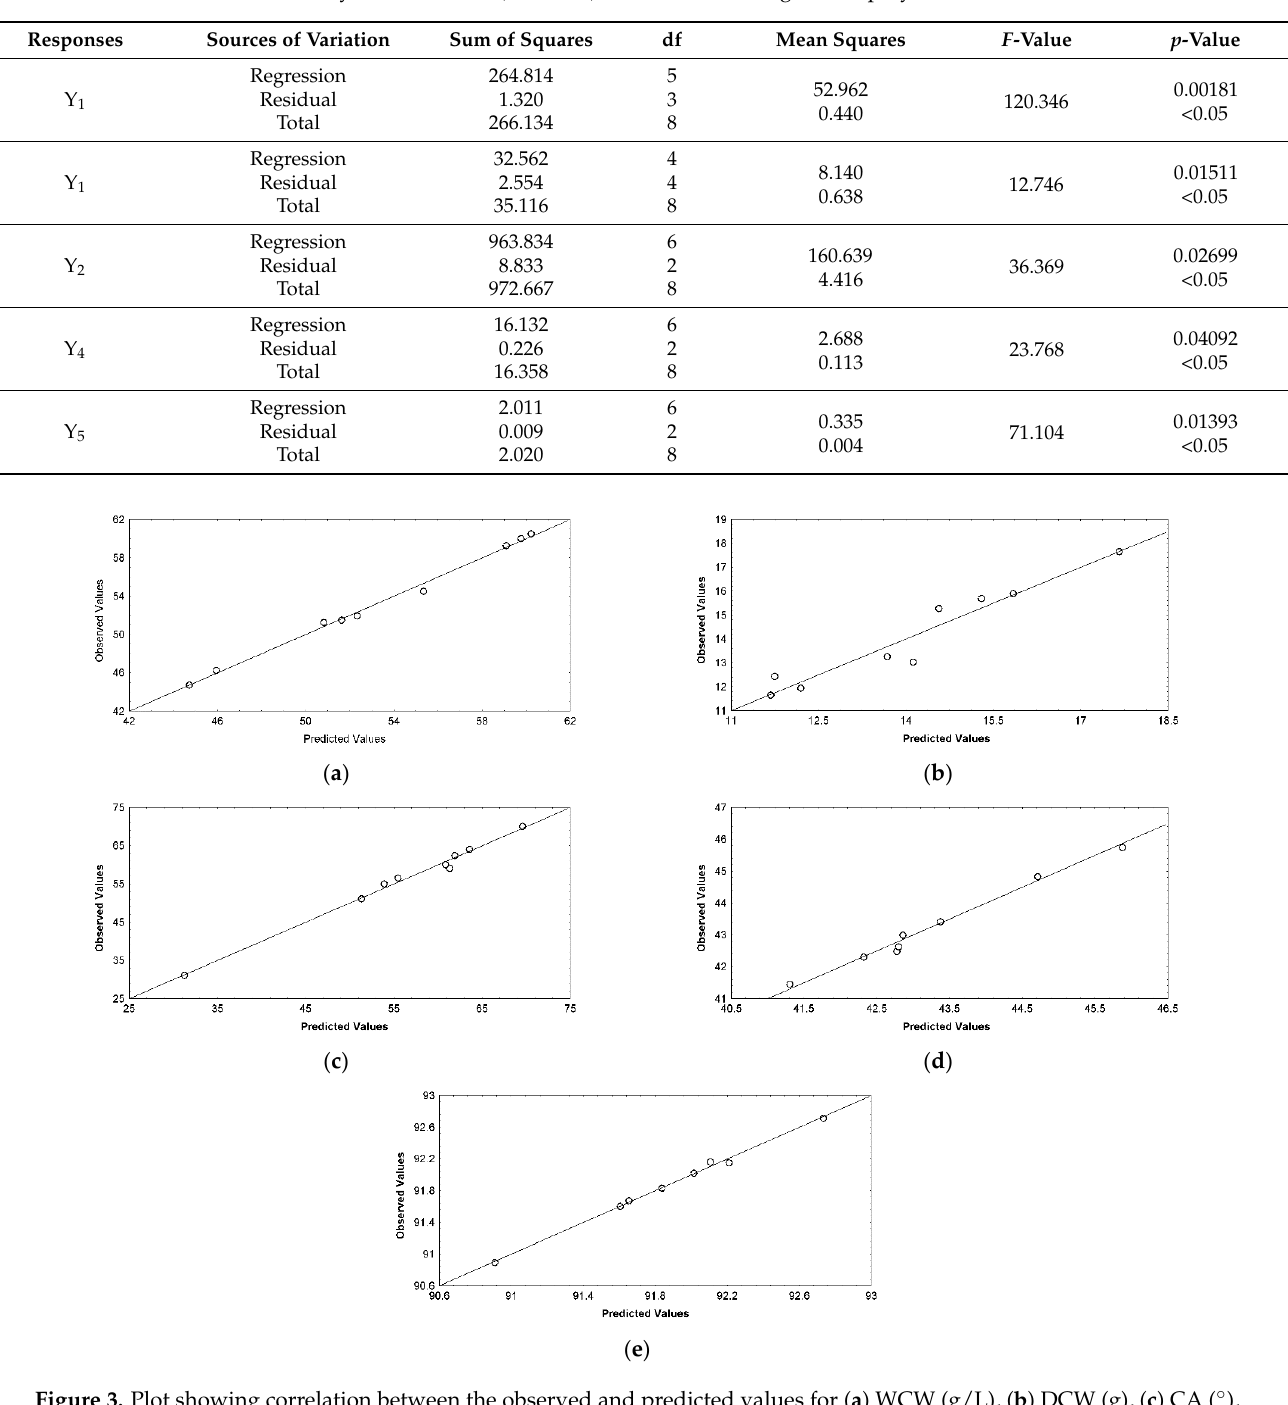
Figure 3. Plot showing correlation between the observed and predicted values for ( a ) WCW (g/L), ( b ) DCW (g), ( c ) CA (°), ( d ) PC (%), and ( e ) DS (%).